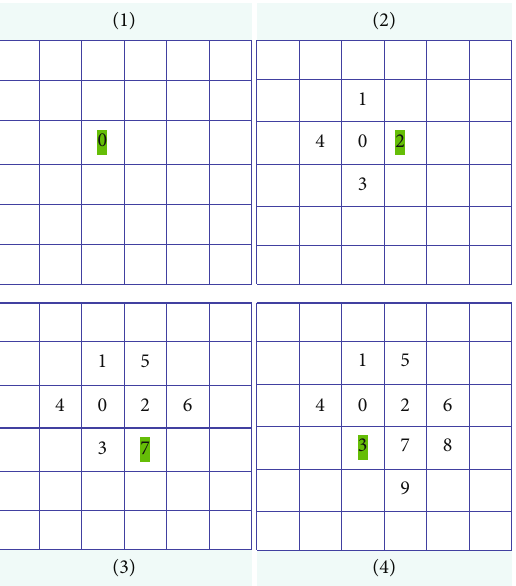
Figure 4: The unwrapping process of the quality-guided anime color fi lling algorithm.